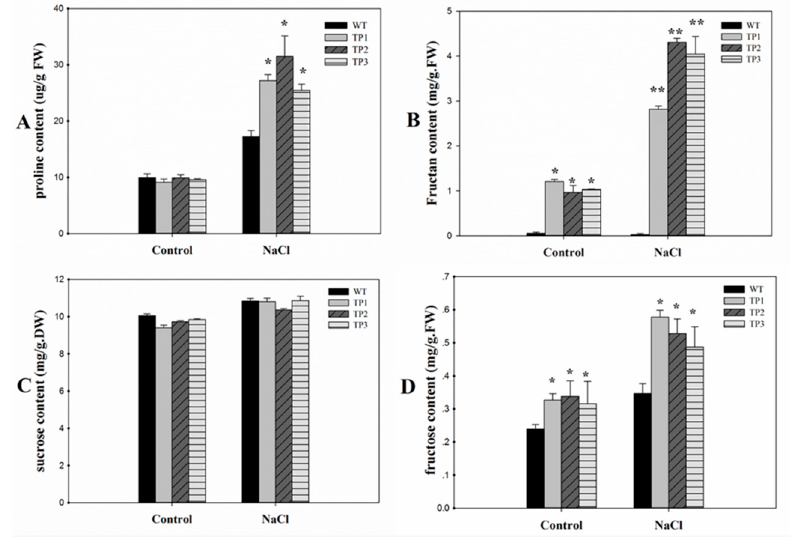
Figure 6. Proline, fructan, sucrose and fructose levels in 3-week-old seedlings of wild-type and transgenic plants under normal and salt stress conditions. ( A ) Proline; ( B ) fructan; ( C ) sucrose; ( D ) fructose. All experiments were repeated at least three times. Error bars indicate the standard deviation (SD). * and ** indicate that the values of the transgenic plants were significantly different from those of the wild type under the same conditions with P < 0.05 and P < 0.01.